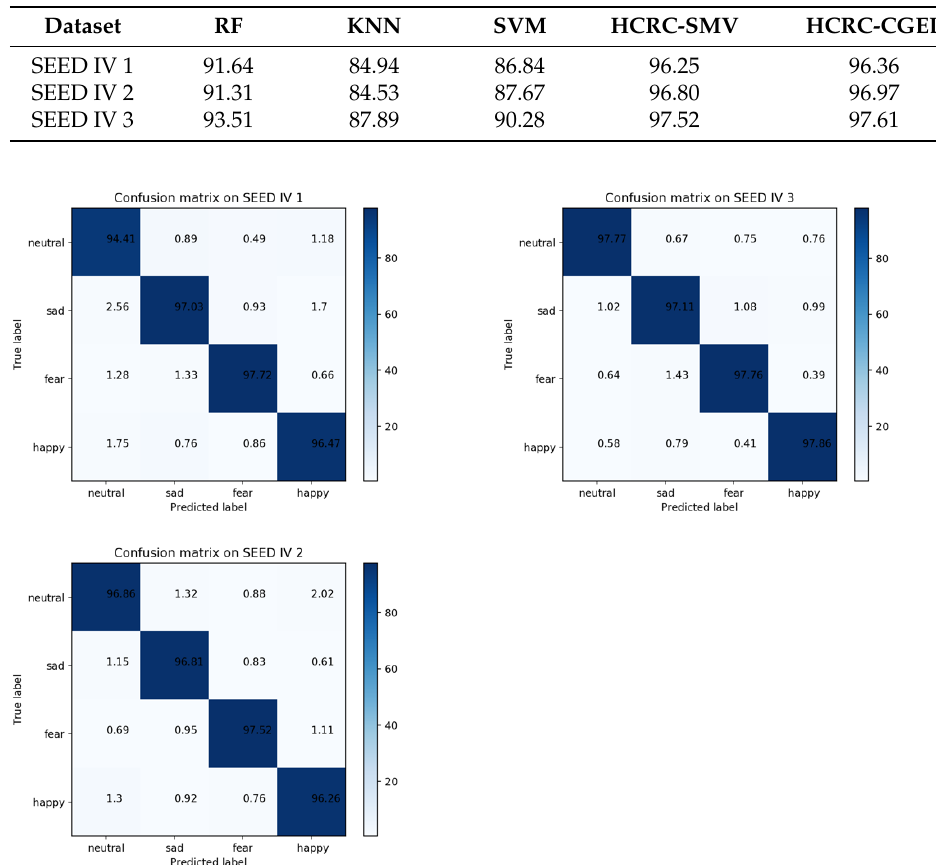
Figure 9. The confusion matrix in the three trials of SEED IV databases.